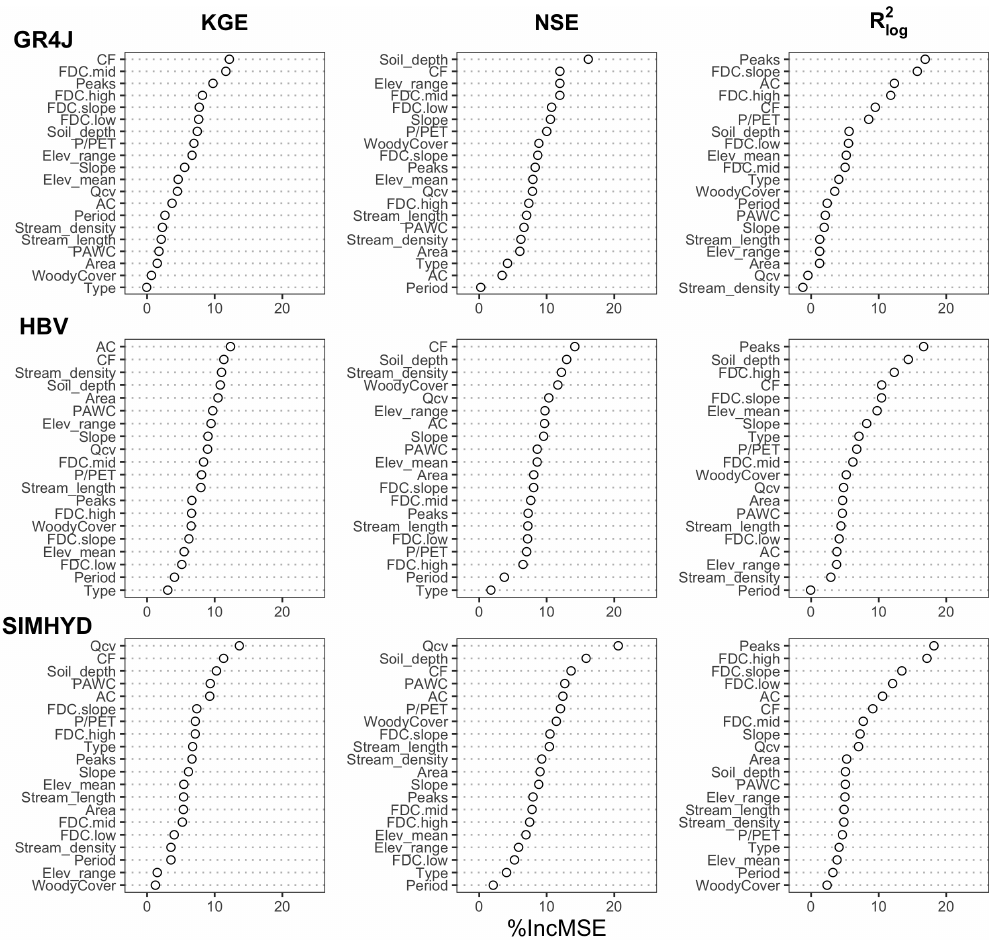
Figure 5. Variable importance in the Random Forest models as measured by the percent increase in mean squared error in the Out-Of-Bag data. The models are in rows and the objective functions are in